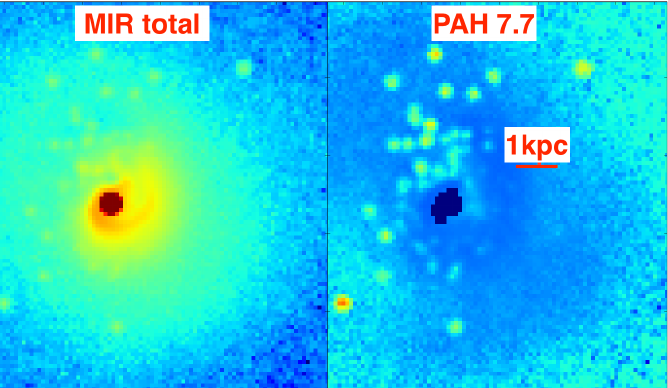
Figure 19. Simulation of a major merger including both strong star-formation and an AGN (from GADGET+Sunrise) illustrating the spatial distribution of the total mid-IR emission as well as high- We will employ simulations to lighting just the PAH emitting regions. One of the most exciting features of the upcoming JWST MIRI interpret our observations of resolved star MRS IFU is the ability to provide high spectral resolution (with the sensitivity to probe sources out to formation and AGN: GADGET hydrodynamic high- z ) but also to look at the spatial distribution of various lines/features. As a guide a 1 kpc scale is simulation (with Sunrise radiative transfer marked—this corresponds roughly to the spatial resolution of JWST /MIRI in its shorter wavelengths at cosmic noon, z processing) showing the total mid-IR light ( left ) ∼ and just the PAH emission ( right ).